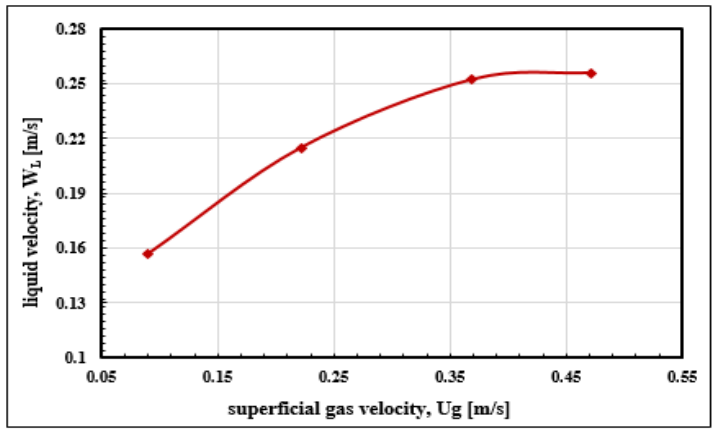
Figure 10. Relationship between actual liquid velocity and superficial gas